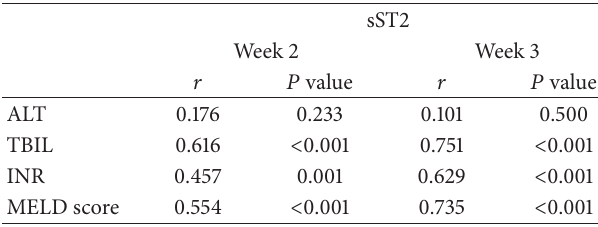
Table 3: Correlations between soluble ST2 (sST2) and clinical markers of disease severity in patients with hepatitis B virus-related acute-on-chronic liver